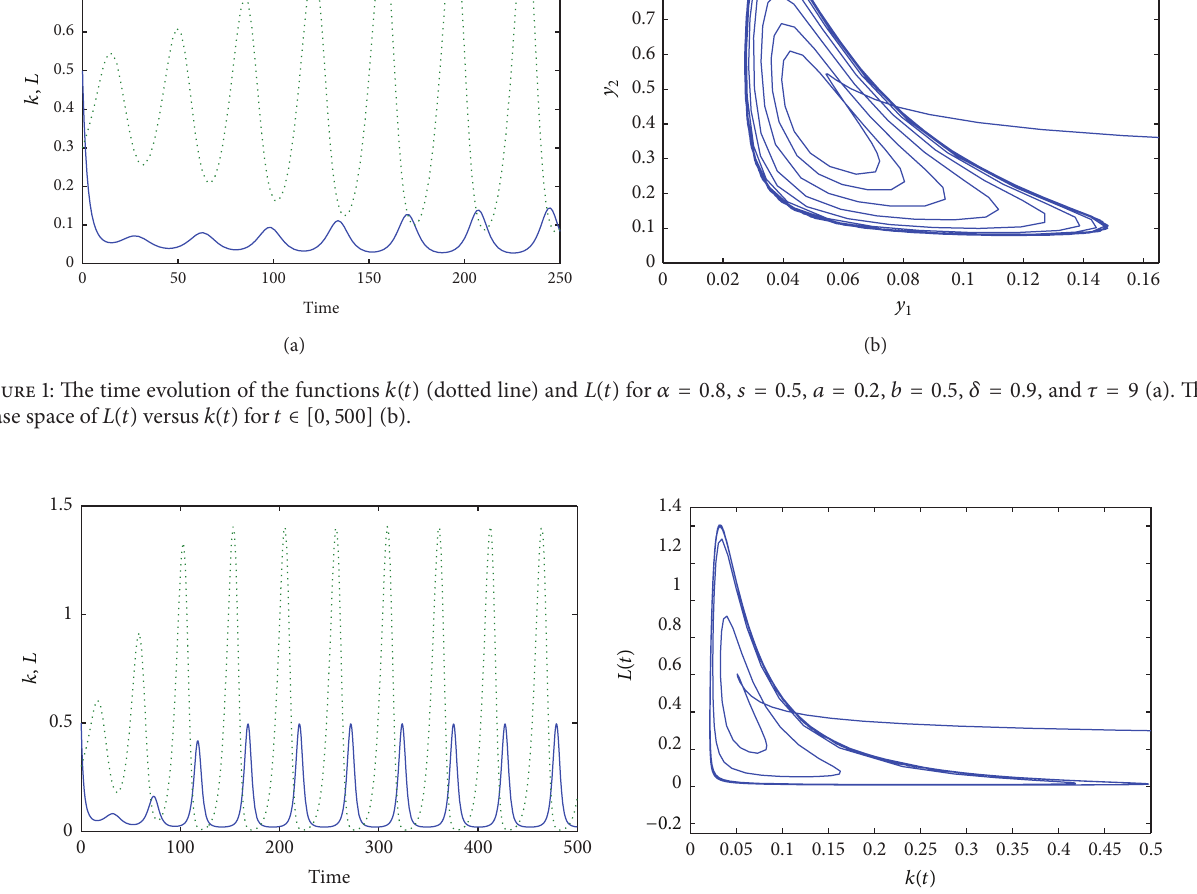
When the magnitude of the time delay decreases, also the oscillations and the cycle limit period decrease; see Figure